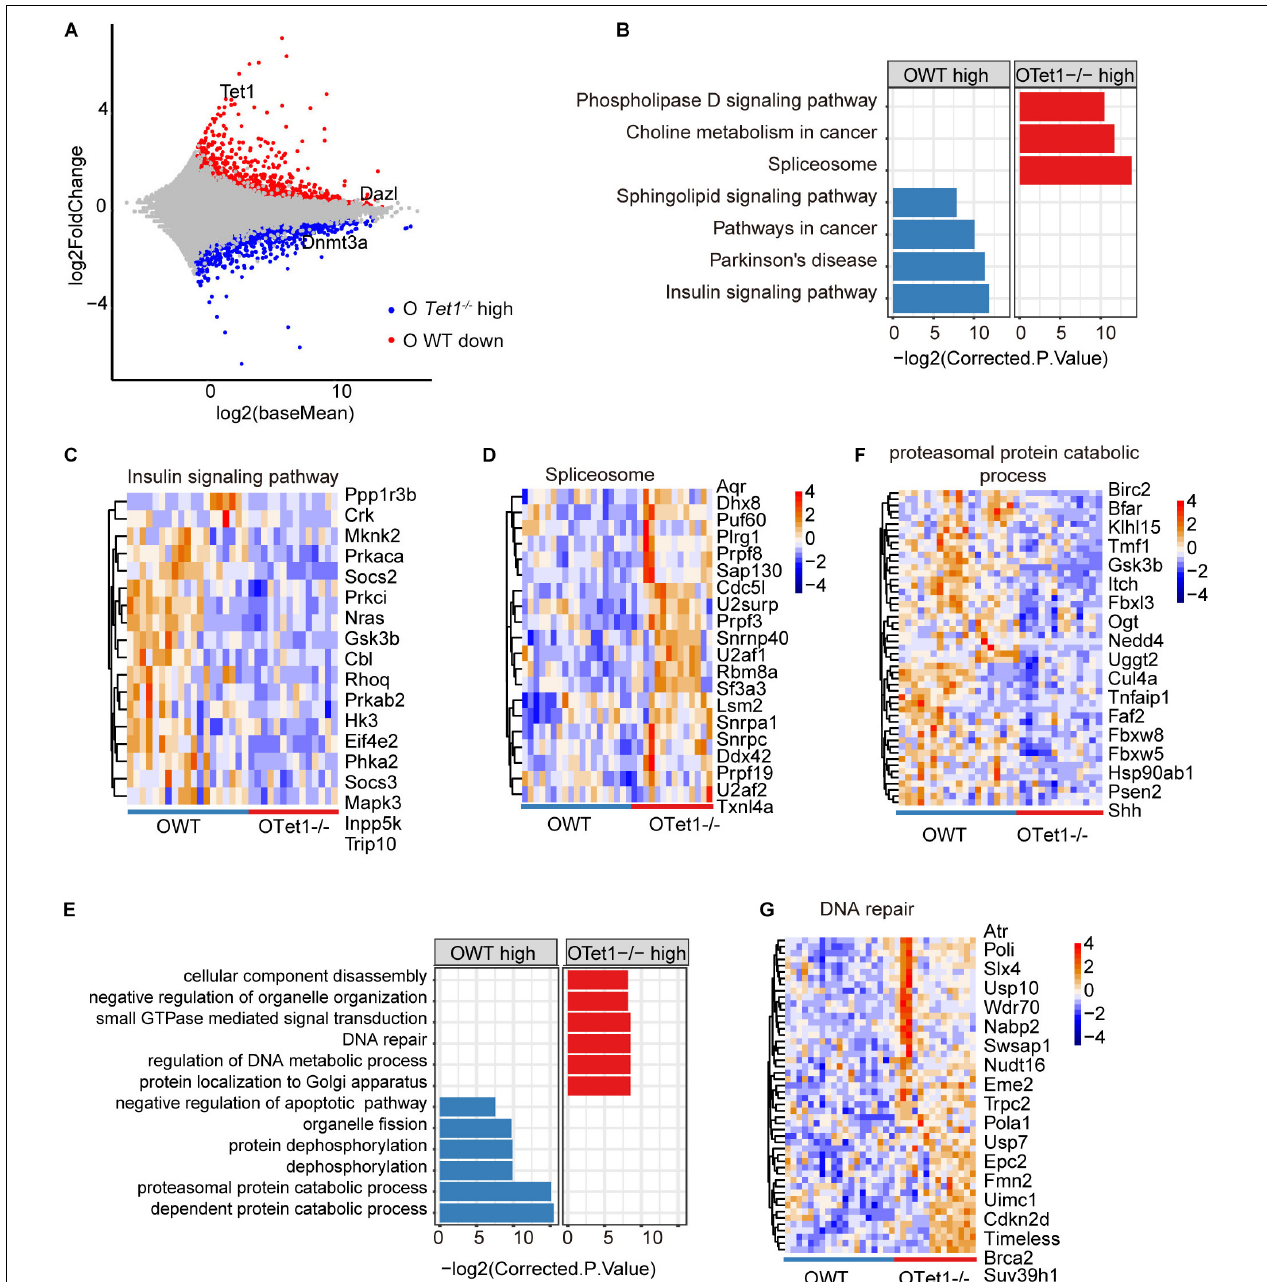
FIGURE 3 | Differential gene expression of old Tet1 − / − and WT oocytes. (A) Scatter-plots showing gene expression profile between old Tet1 − / − ( n = 14) and WT ( n = 19) oocytes from two biological repeats. (B) KEGG enrichment results showing genes downregulated or upregulated after Tet1 deficiency. X -axis represents the corrected p value (FDR) using Benjamini and Hochberg. (C) Pheatmap showing genes enriched in insulin signaling pathway in Tet1 deficient oocytes. (D) Pheatmap showing genes enriched in spliceosome in Tet1 deficient oocytes. (E) GO enrichment results showing genes downregulated or upregulated after Tet1 deficiency. X -axis represents the corrected p value (FDR) using Benjamini and Hochberg. (F) Pheatmap showing genes enriched in proteasomal protein catabolic process in Tet1 deficient oocytes. (G) Pheatmap showing genes enriched in DNA repair in Tet1 deficient oocytes.